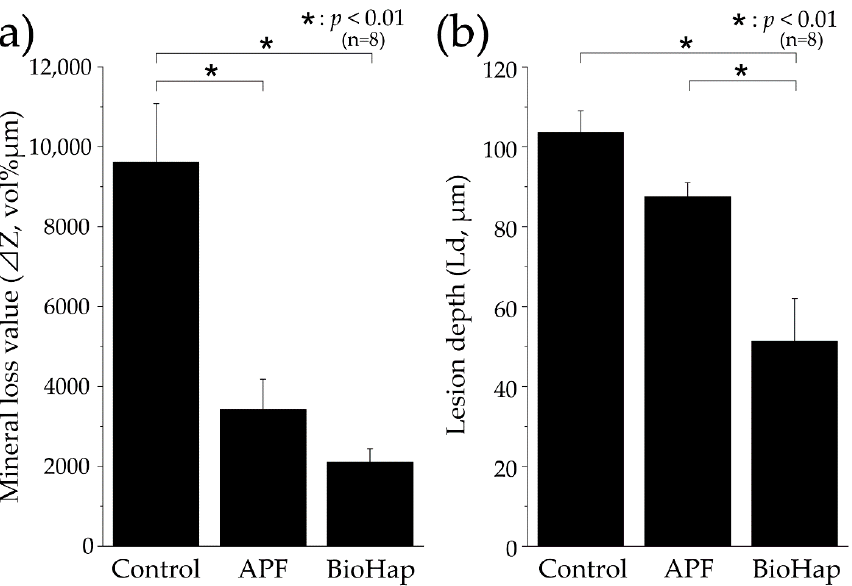
Figure 7. Graphical representations of mineral loss value ( Δ Z) and lesion depth (Ld) after acid challenge. ( a ) Graphical representation of mineral loss value ( ∆ Z, n = 8, * p < 0.01). All eight samples were measured, and the mean ± standard deviation values were determined. ( b ) Graphical representation of Ld (n = 8, * p < 0.01). The depth of demineralization was determined from the surface before the demineralization experiment to a site with 95% healthy enamel. All eight samples were measured, and the mean ± standard deviation values were determined.